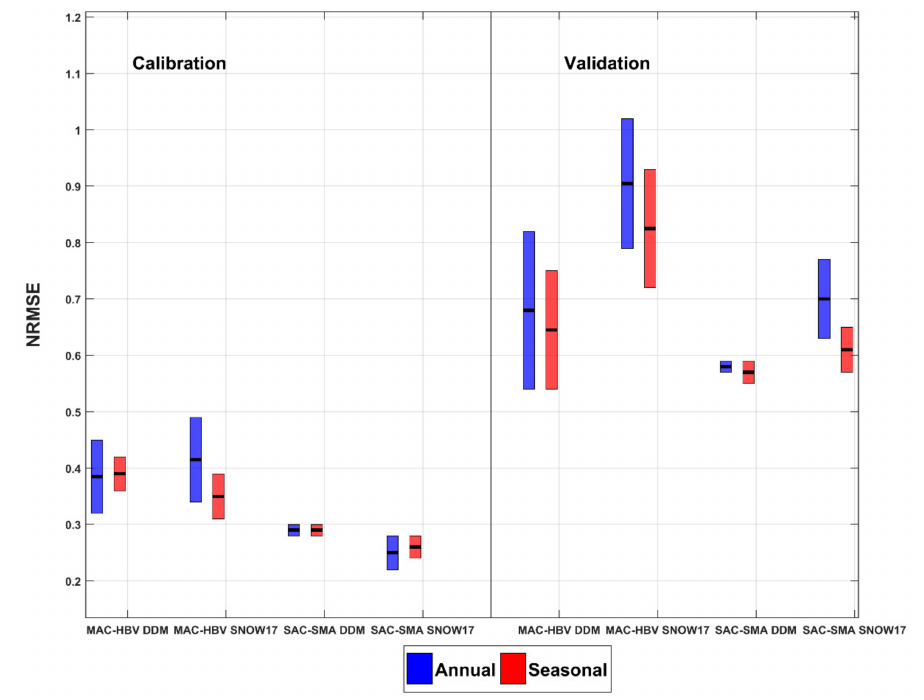
Figure 8. NRMSE statistics for MAC-HBV-DDM, MAC-HBV-SNOW-17, SAC-SMA-DDM, SAC-SMA- SNOW-17 model combinations for annual and seasonal models of UASR. See Figure 6 for box plot